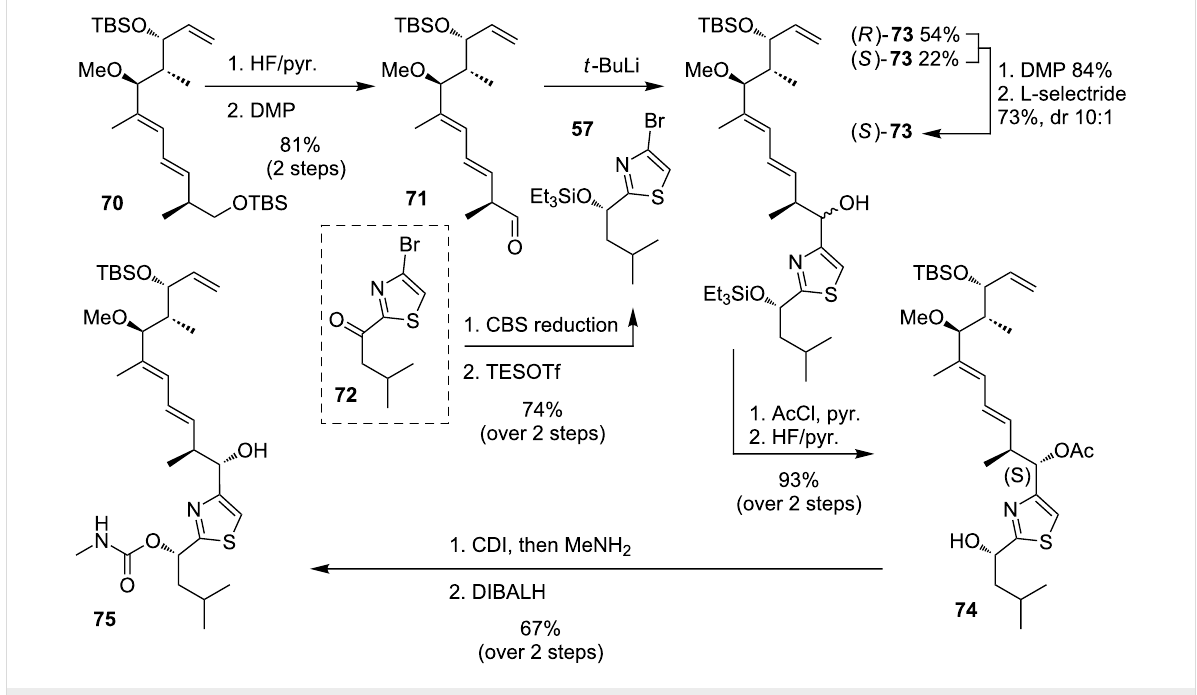
Scheme 14: Organometallic addition of the side chain to access free alcohol 75